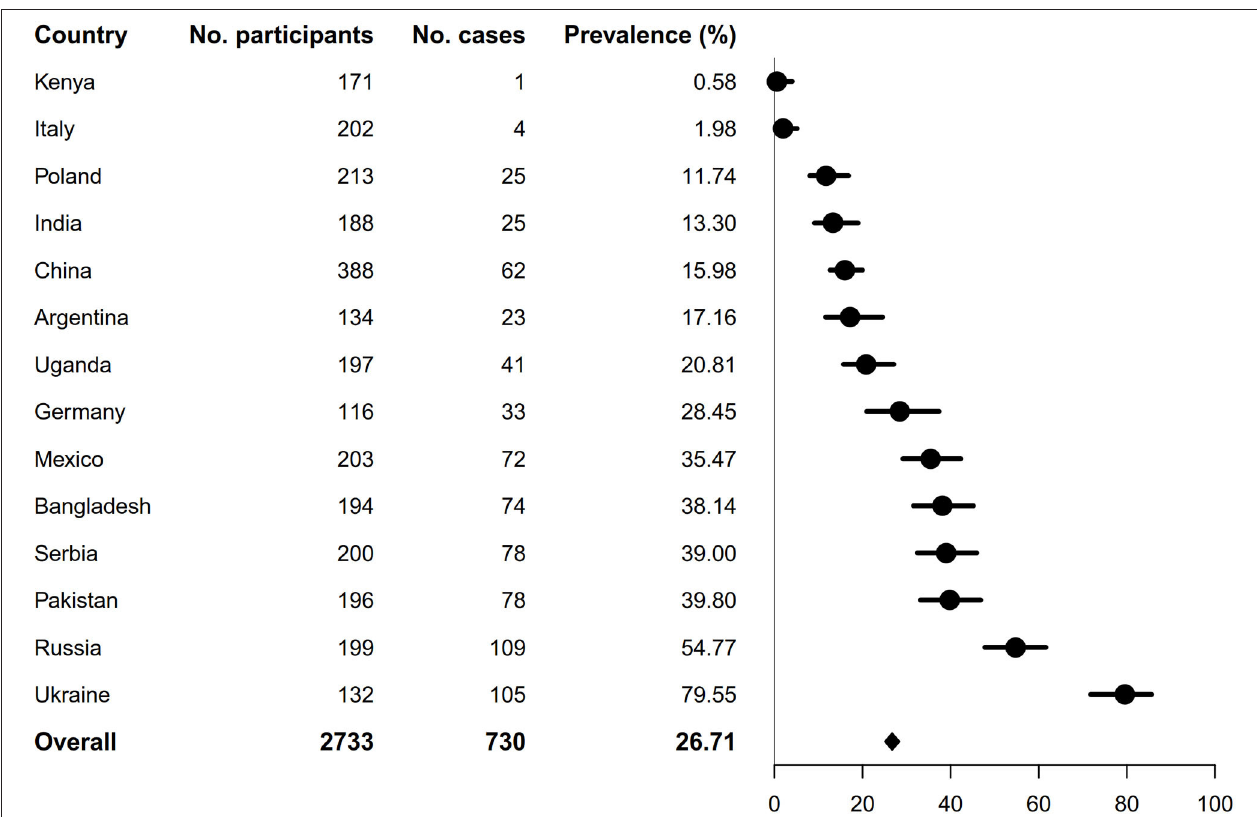
FIGURE 1 | Prevalence of diabetic neuropathy by